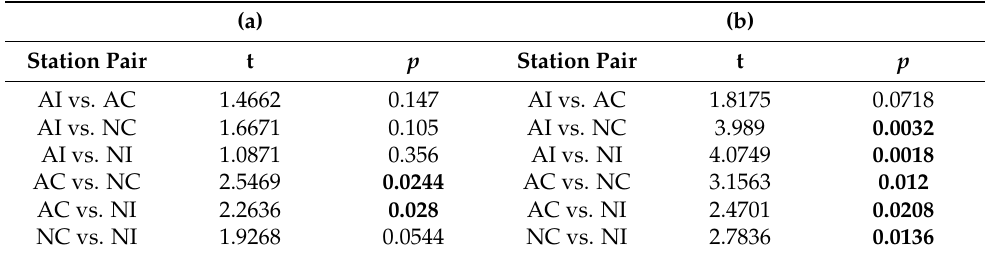
Table 2. Pair-wise comparisons and t-statistics for differences in total meiobenthic assemblages among stations, within levels of the depth factor. Significant tests relevant to the hypothesis are given in bold. ( a ) Within level ‘20’ of factor ‘Depth’. ( b ) Within level ‘50’ of factor ‘Depth’. (a) (b) Station Pair t p Station Pair